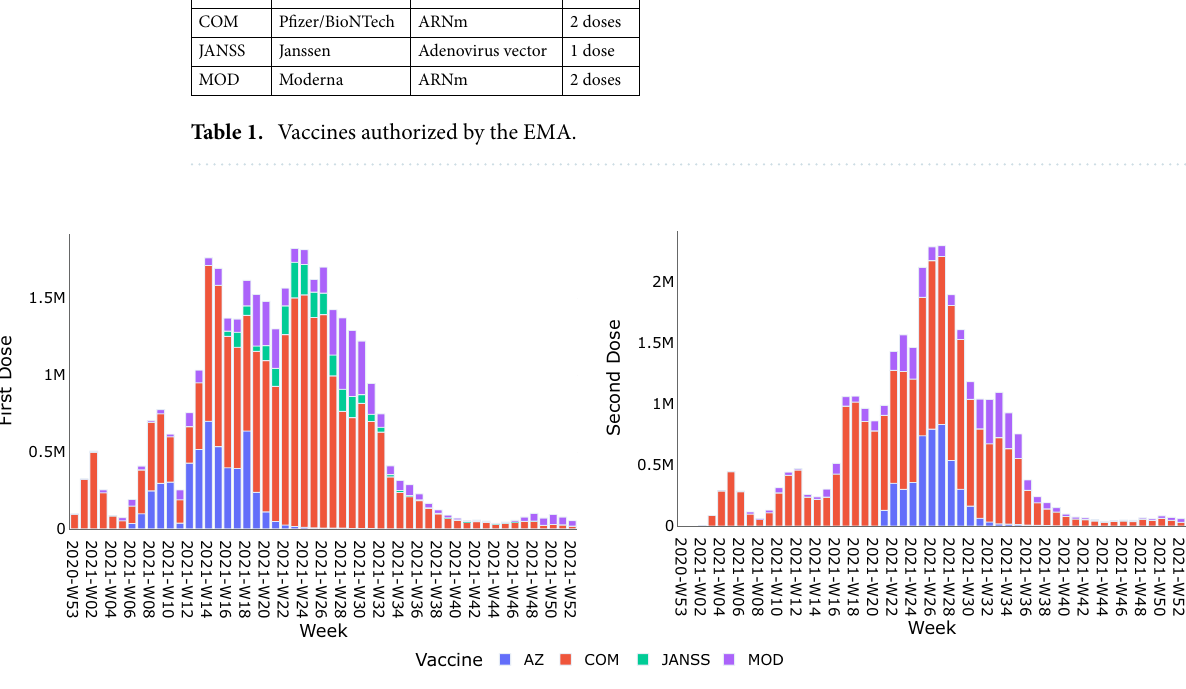
Figure 3. First and second doses of the COVID-19 vaccine given in Spain by week and type of